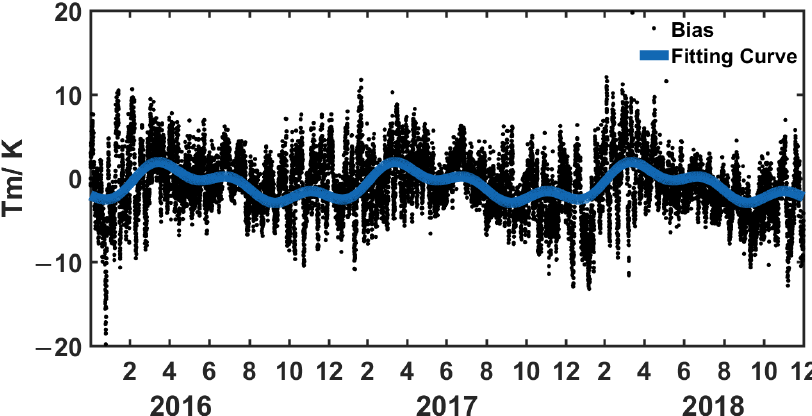
Table 3. Fourier coefficients of the GPT3- 𝑇 (cid:3040) bias in the Yangtze River Delta region during the 2016– 2018 period. Figure 6. The bias and fitting curve of the GPT3- 𝑇 (cid:3040) in the Yangtze River Delta region during the 2016–2018 period. 2016–2018